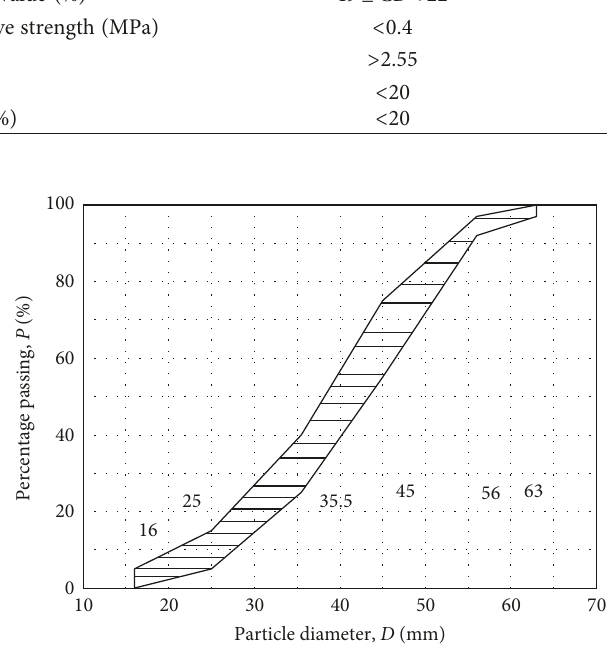
Figure 2: Ballast grain size